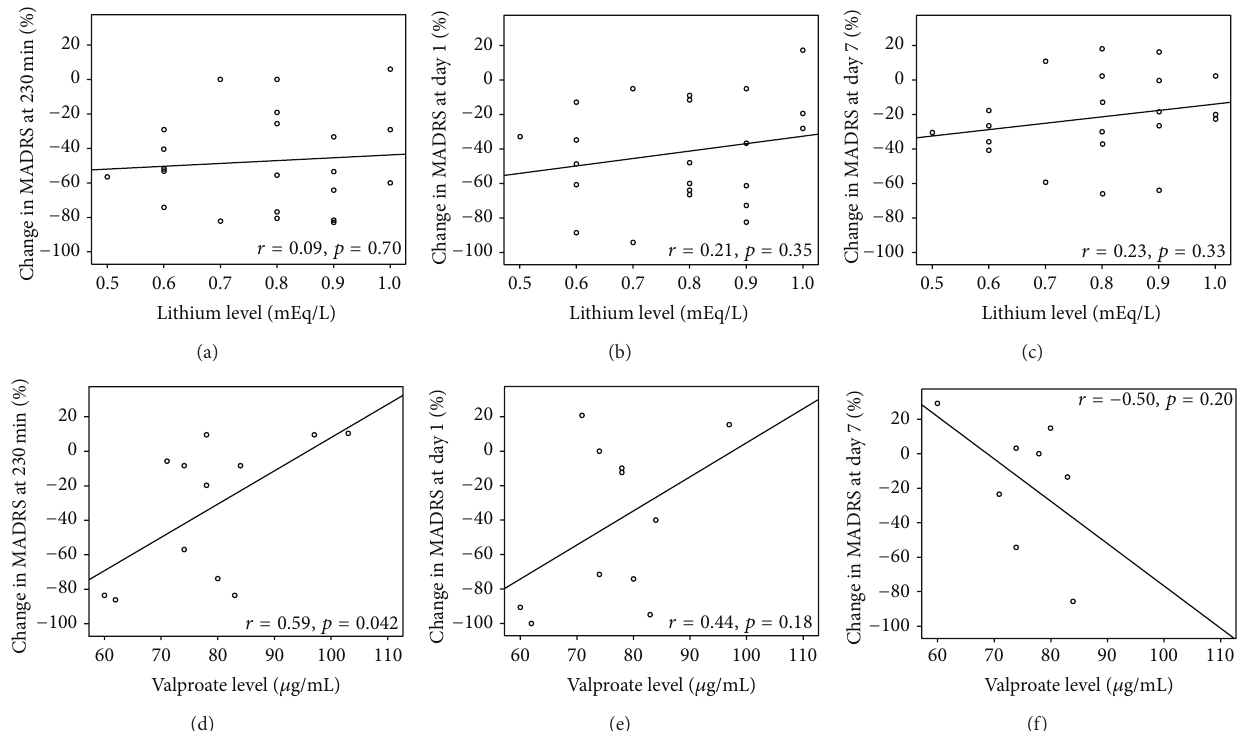
Figure 2: Therapeutic serum levels of lithium and valproate did not correlate with ketamine’s antidepressant efficacy. Treatment-resistant patients with bipolar disorder (BD) currently experiencing a major depressive episode were maintained on therapeutic but subeffective serum levels of lithium or valproate for at least four weeks. Mean same-day pre-ketamine lithium ( 𝑛 = 22 ) and valproate ( 𝑛 = 12 ) levels were 0.79 ± 0.15 mEq/L and 79.6 ± 12.4 mg/mL, respectively. These levels correlated with ketamine’s antidepressant efficacy at three time points: 230 minutes (same-day/hyperacute), day one (next-day/acute), and day seven (sustained) after ketamine infusion. Serum lithium levels did not correlate with ketamine’s antidepressant efficacy at these three time points (a). Serum valproate levels positively correlated with ketamine’s antidepressant efficacy at 230 minutes after infusion, 𝑟 = 0.59 , 𝑝 = 0.04 , but this did not survive adjustment for multiple comparisons ( 𝑝 adjusted = 0.12 )